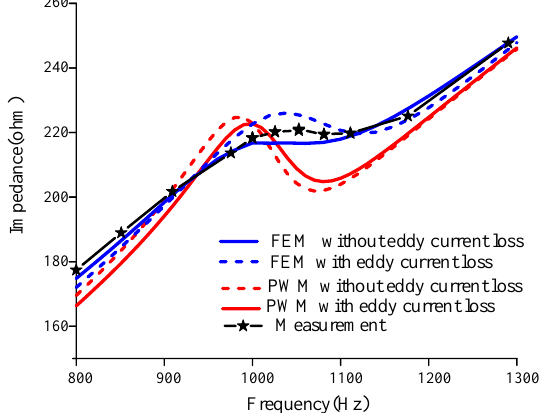
Figure 15. Comparison of the impedance for PWM, FEM, and measurement.